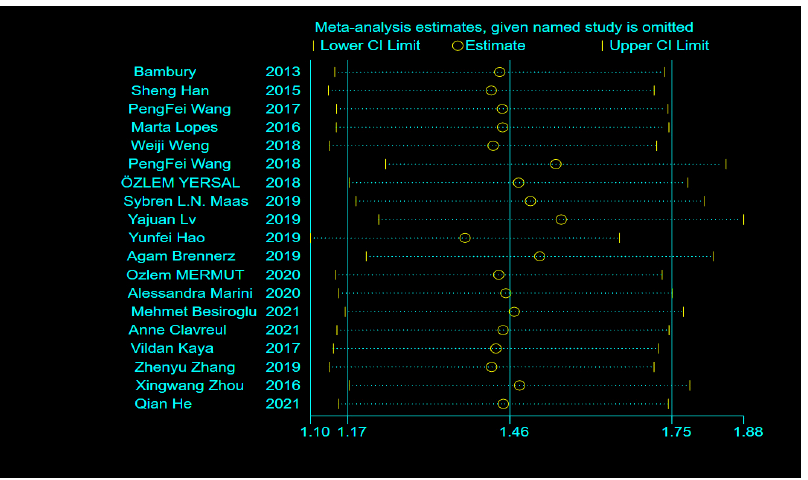
Figure 4. Sensitivity analysis of the relationship between single studies and heterogeneity in the included literature.